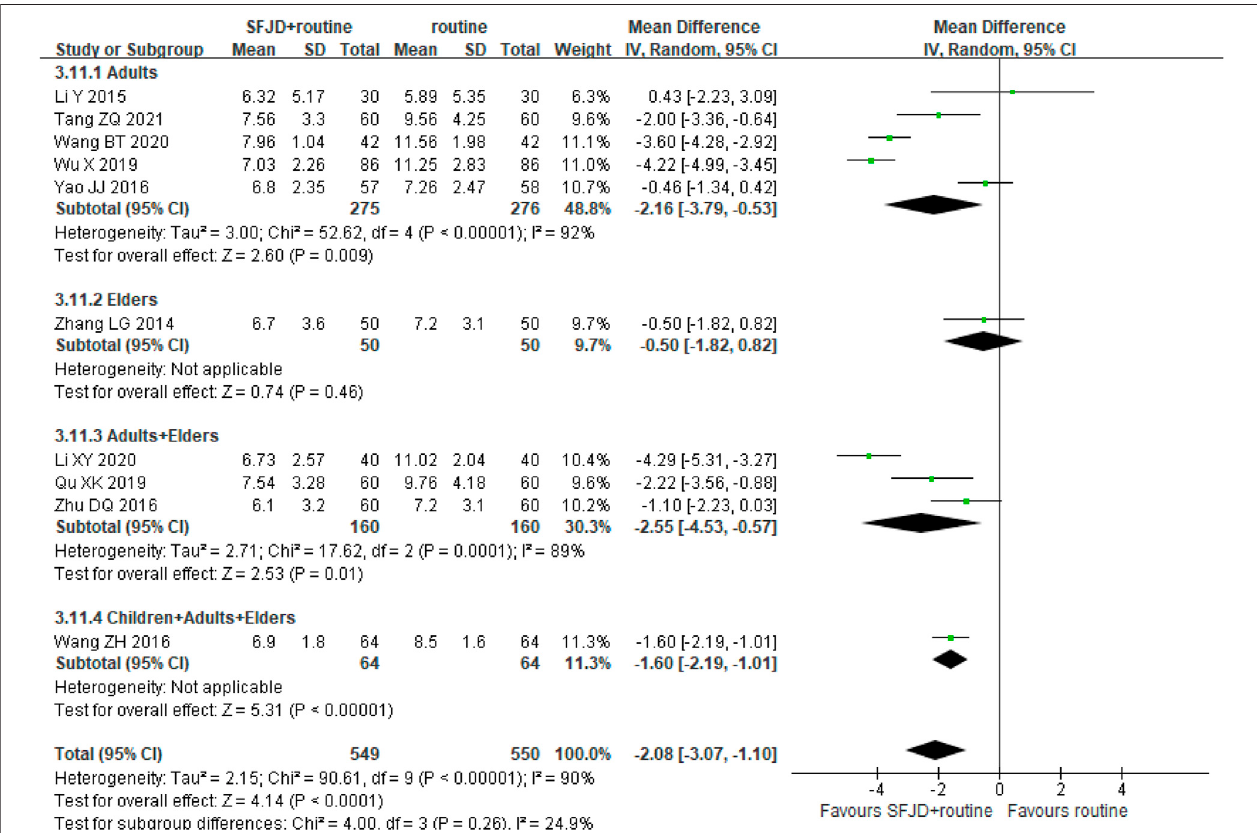
FIGURE 6 | Forest plot of white cell count strati fi ed by age (×10 9 /L). Comparison: SFJD plus routine treatment vs. routine treatment. SFJD: Shufeng Jiedu.